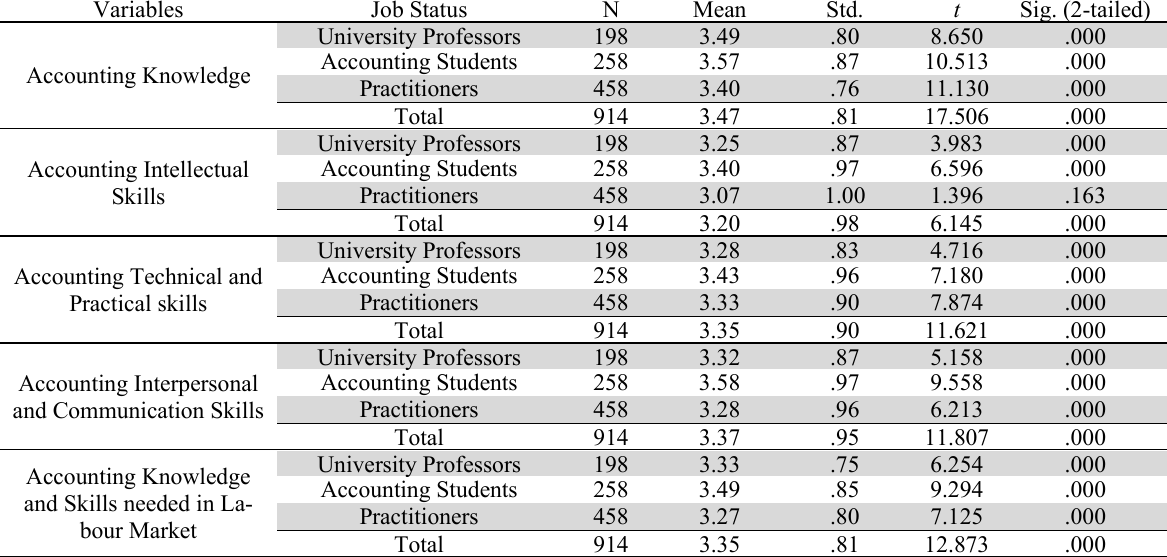
One-Sample t test of Accounting Education offered and Requirements by the Labour Market Variables Job Status N Mean Std. t Sig. (2-tailed)